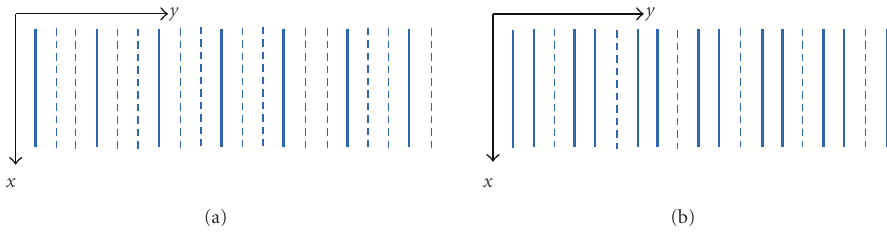
Figure 2: (a) Electron configuration at ν = 1 / 3. (b) Configuration at ν = 2 /